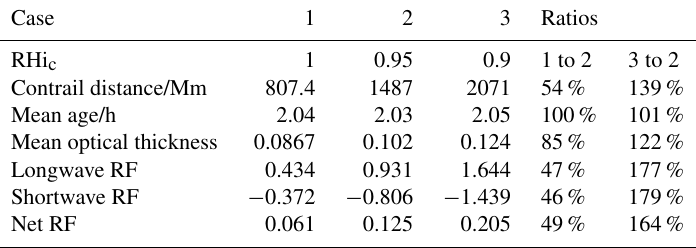
Table 7. Sensitivity to the mean ice supersaturation parameter RHi c , absolute values, and ratios relative to reference case 2 for July 2020. Case